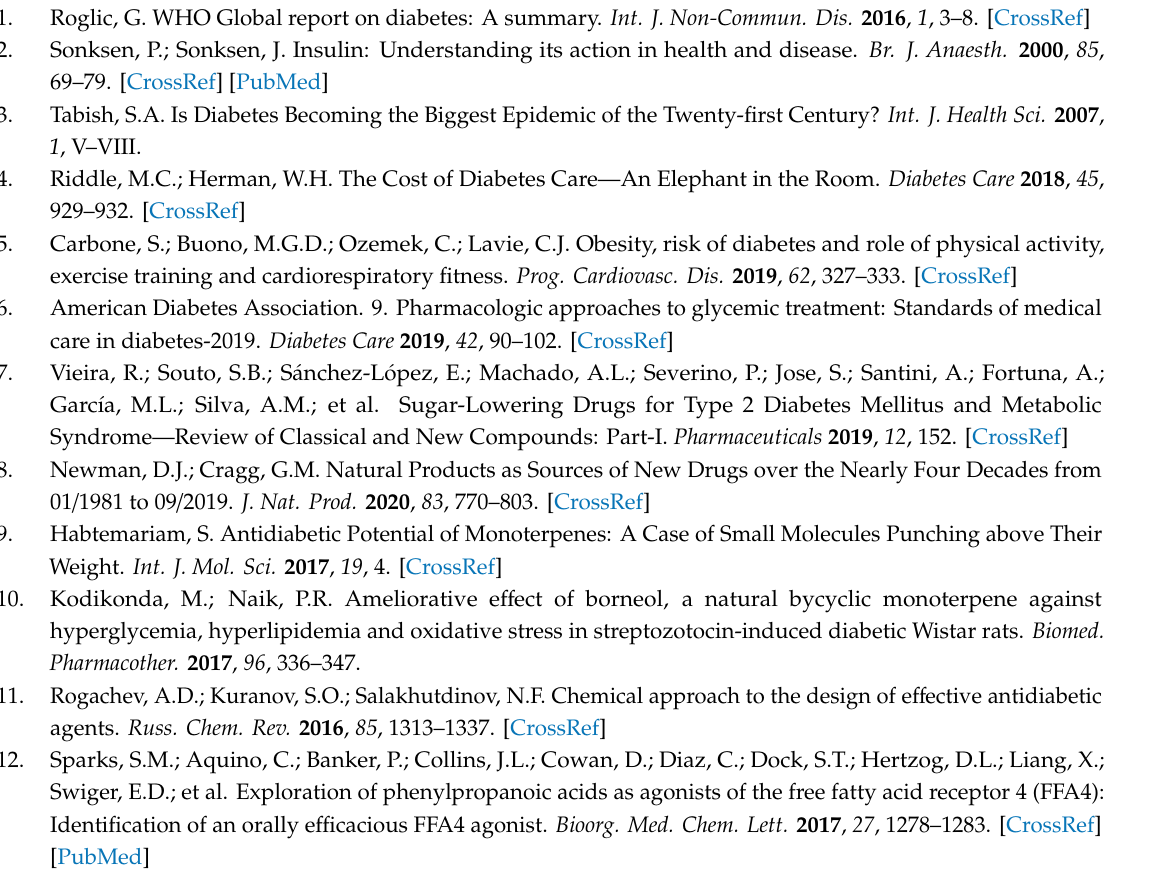
s1. Figure S1. 1H NMR spectrum of compound 2 . Figure S2. 13C NMR spectrum of compound 2. Figure S3. 1H NMR spectrum of compound 3 . Figure S4. APT spectrum of compound 3. Figure S5. 1H NMR spectrum of compound 4 . Figure S6. APT spectrum of compound 4. Figure S7. 1H NMR spectrum of compound 12 . Figure S8. 1H NMR spectrum of compound 13 . Figure S9. APT spectrum of compound 13 . Figure S10. 1H NMR spectrum of compound 14. Figure S11. APT spectrum of compound 14 . Figure S12. 1H NMR spectrum of compound 15. Figure S13. APT spectrum of compound